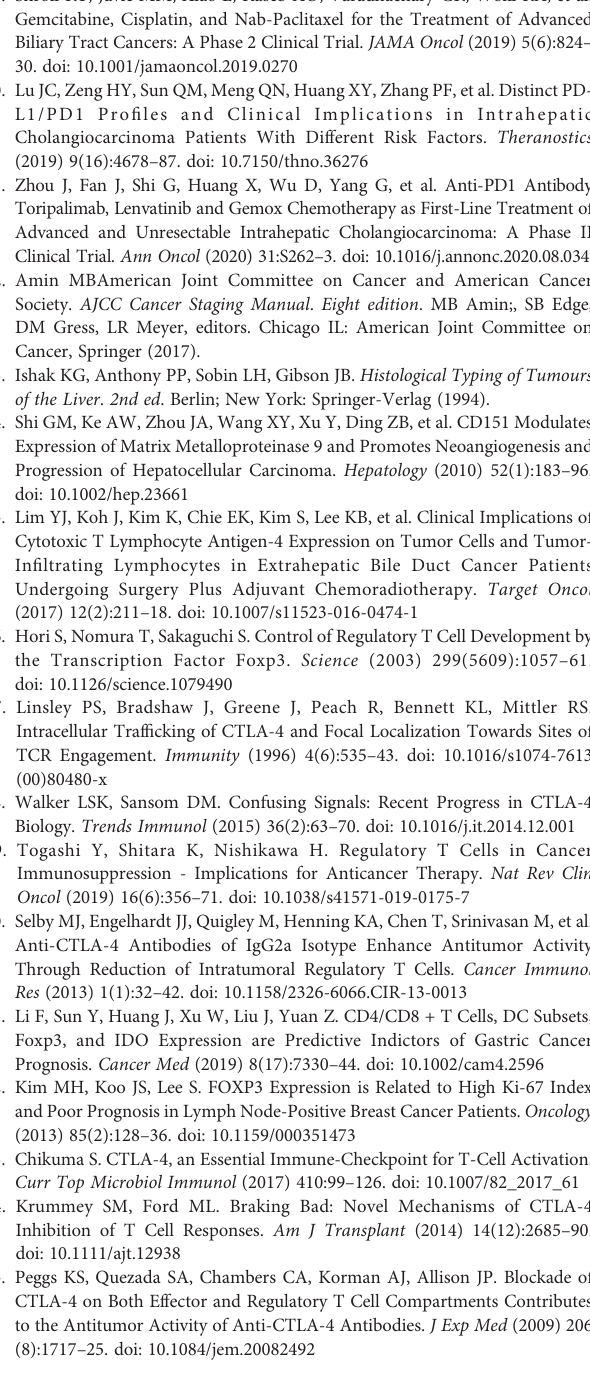
was higher than paired FOXP3 + in fi ltrating lymphocytes in the whole ICC cohort ( P < 0.001, paired Student ’ s t-test). (B) Density of FOXP3 + tumor in fi ltrating lymphocytes was higher in Tumor PD-L1 High /TILs CTLA-4 Low patients than Tumor PD-L1 Low /TILS CTLA-4 High patients ( P < 0.001, paired Student ’ s t-test). (C) Density of FOXP3 + tumor in fi ltrating lymphocytes was higher in Tumor PD-L1 High patients than Tumor PD-L1 Low patients ( P < 0.001, paired Student ’ s t-test). *** P <